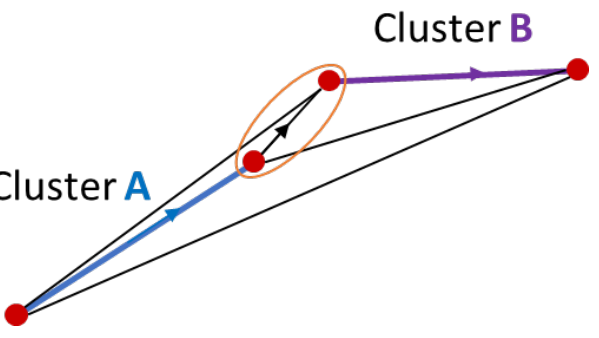
Figure 6. Crack point clusters are represented as graphs.